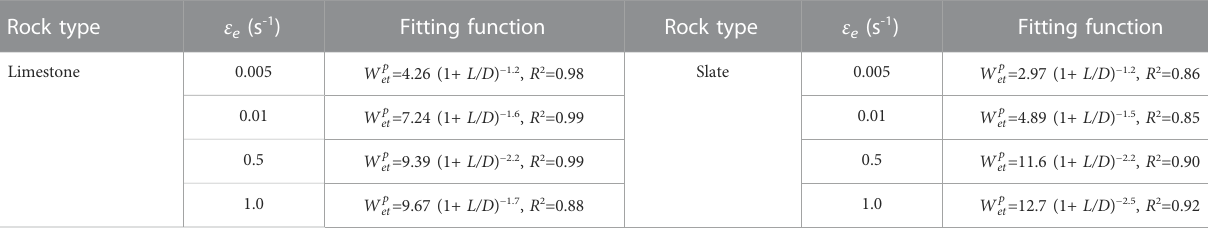
TABLE 4 Fitting formula of W p et versus L/D ratio. Rock type Limestone